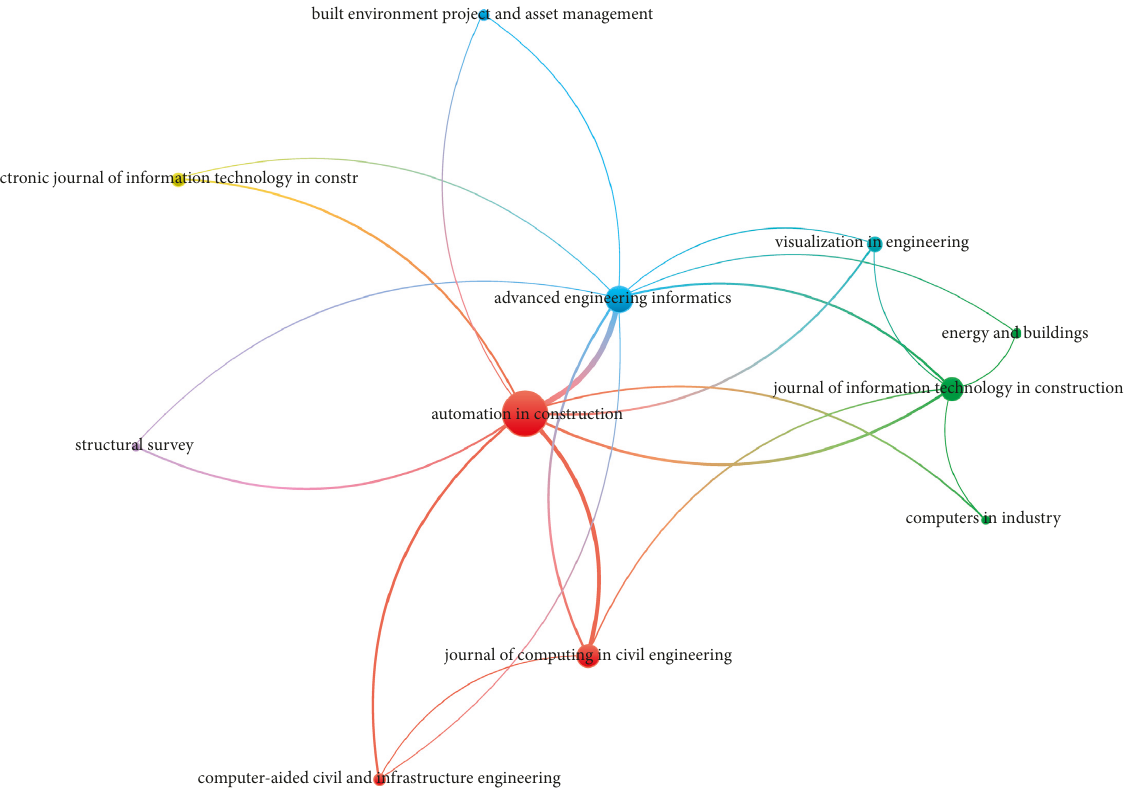
Figure 7: Citation network of journals.